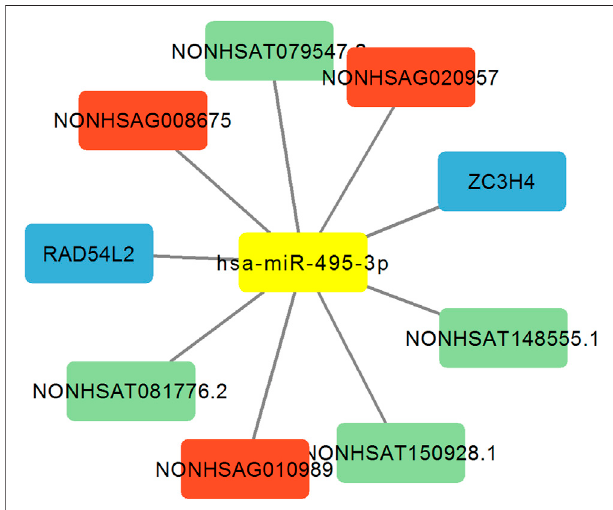
FIGURE 4 | Analysis of the lncRNA-miRNA495-mRNA network. Red indicates lncRNA sponge of miR-495. Blue indicates mRNA target of miR- 495. Green indicates lncRNA target of